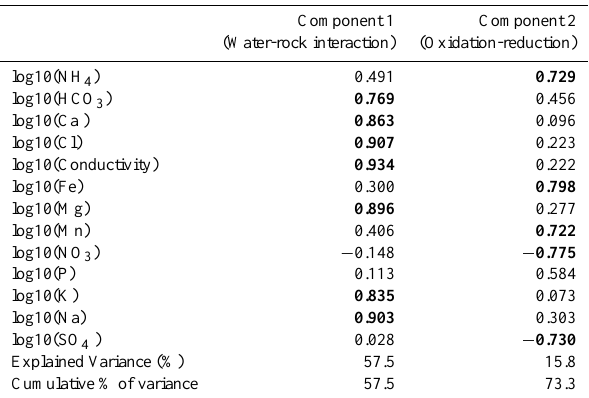
Table 3. Principal component weightings and explained variance for the two significant components. Component scores presented in bold show the highest weighting for each component. Component